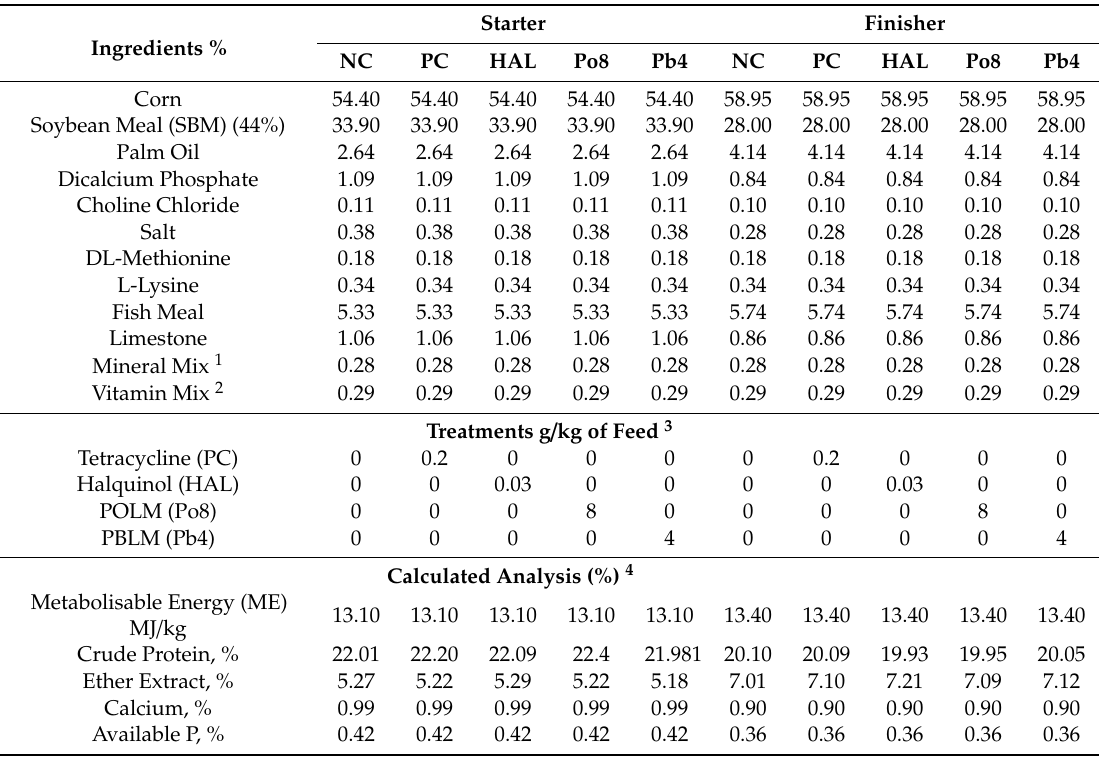
Table 1. Ingredient (% as feed) and nutritional analysis feed used in the current